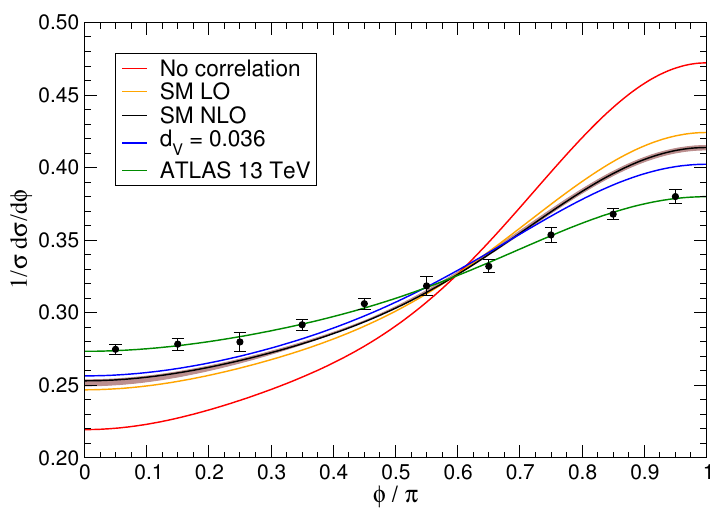
Figure 6 . Di(cid:11)erent predictions for the azimuthal distribution at 13 TeV, compared to the ATLAS